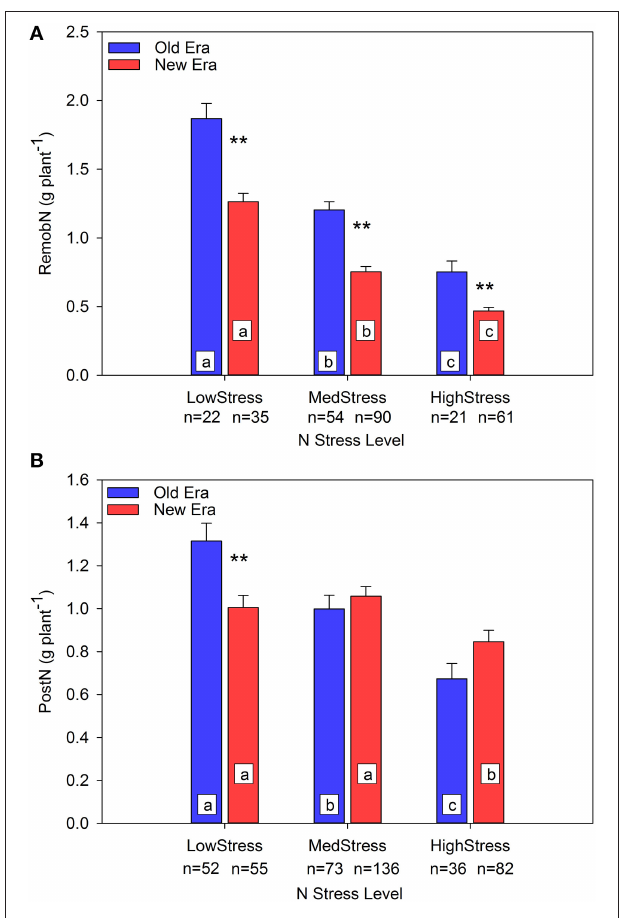
FIGURE 2 | Relationship between N stress level, as determined by NNI at R1, and remobilized N (RemobN) (A) and post-silking N uptake (PostN) (B) in g plant − 1 for the Old and New Eras. Different letters signify LSMeans within Eras (Old or New) are significantly different across N stress levels. An ** denotes a significant difference between the Old and New Era LSMeans within a given N stress level. ** denotes significance at the 0.01 probability level.